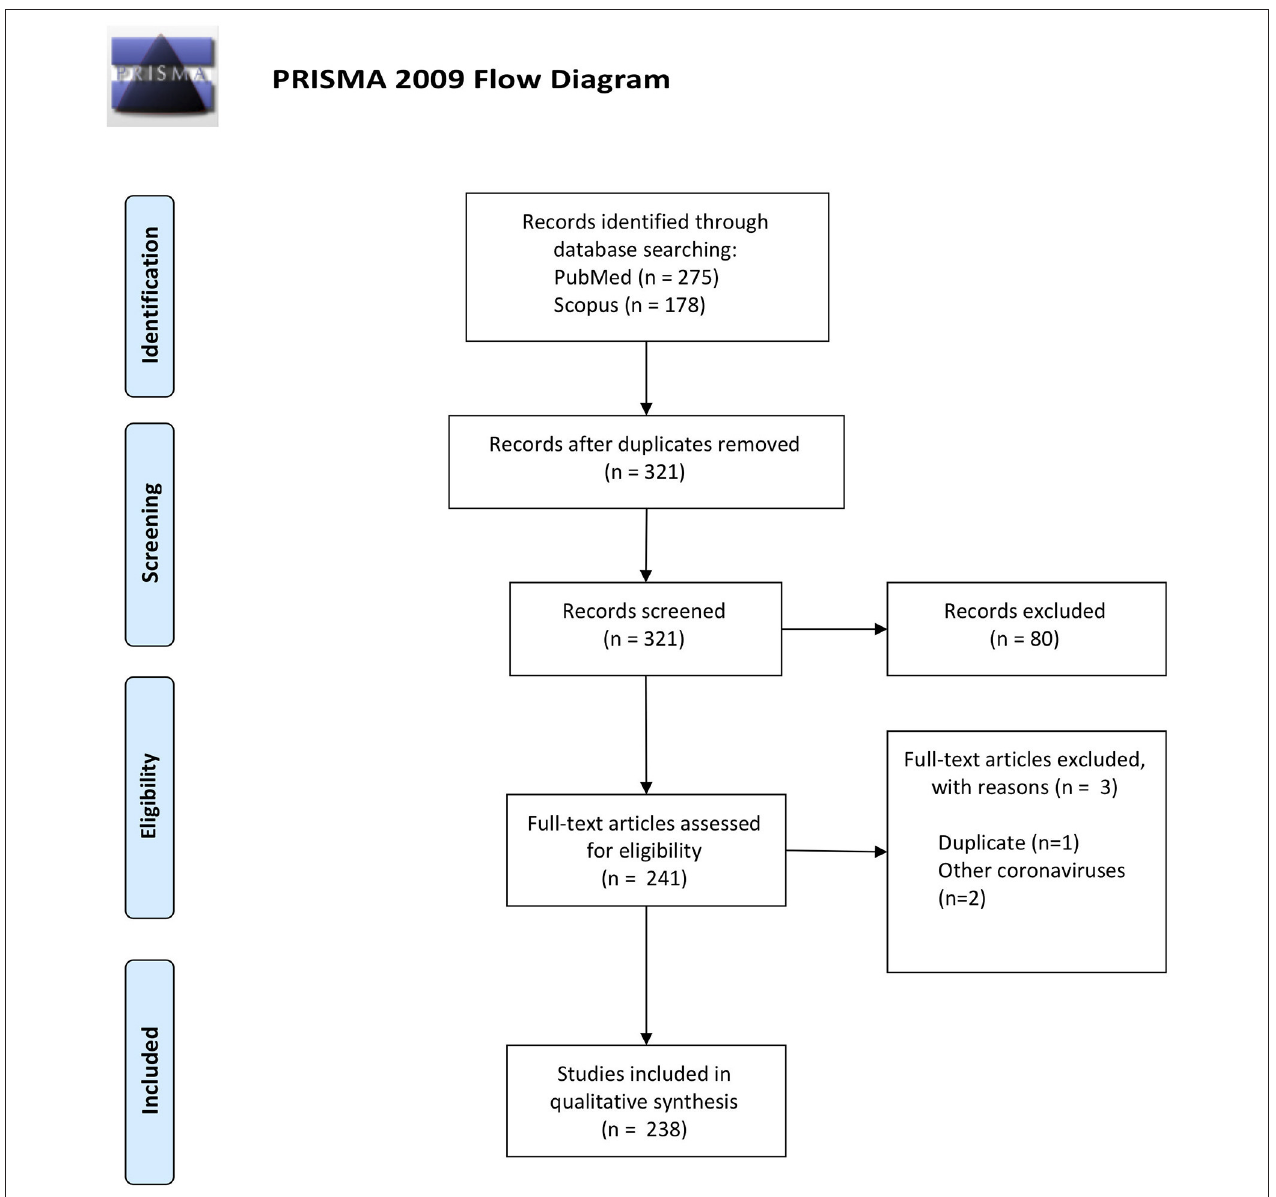
FIGURE 1 | PRISMA diagram of the study selection process.